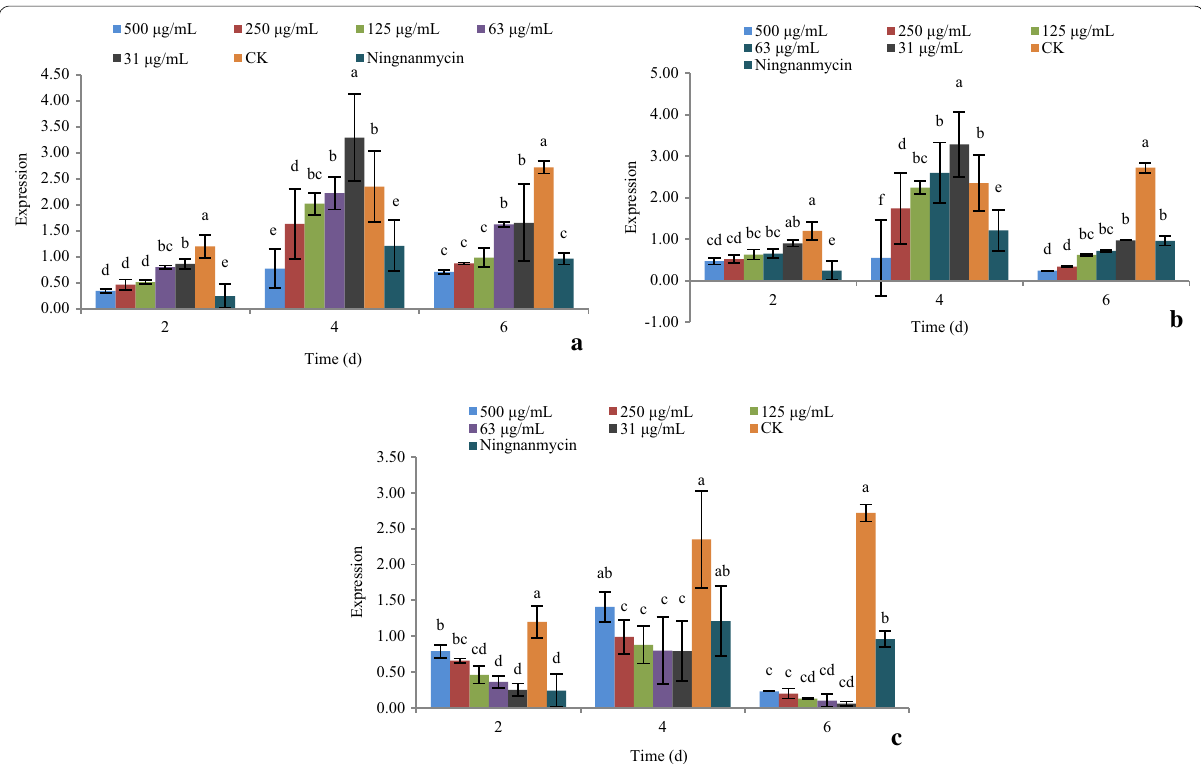
Fig. 7 The effect of active compounds 1 , 5 , and 9 on the expression of gene CPIP3 . a Compound 1 ; b Compound 5 ; c Compound